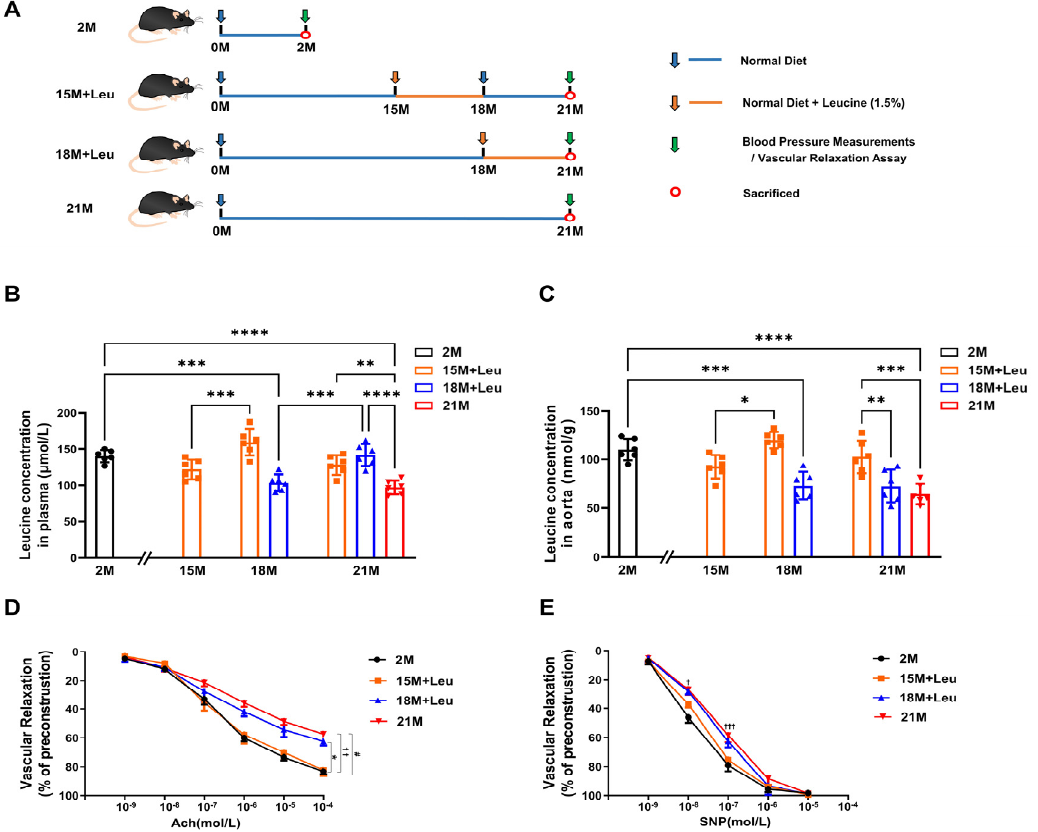
Figure 1. Leucine supplementation from 15M alleviated aging-induced vascular dysfunction. The design of study is shown in ( A ). Measurements of leucine levels in plasma and aorta are shown in ( B , C ). Acetylcholine − mediated endothelium − dependent relaxation and SNP − mediated endothe- lium − independent relaxation are presented in ( D , E ). Statistical analysis of leucine measurements was performed using one − way ANOVA, * p < 0.05, ** p < 0.01, *** p < 0.001, **** p < 0.0001. Statistical analysis of vascular relaxation curves was performed using two − way ANOVA, * p < 0.05 18M + Leu vs. 2M group, † p < 0.05 21M vs. 2M group, †† p < 0.01 21M vs. 2M group, ††† p < 0.001 21M vs. 2M group, # p < 0.05 18M + Leu vs. 15M + Leu group. All data are presented as mean ± SEM, n = 6/group. Vascular remodeling was determined using H&E, Masson’s Trichrome, and van Gie- son’s staining. Compared with the aged group without leucine supplementation, the aor- tas from the 15M + Leu group had a 15.1% reduction in the lumen diameter and a 14% decrease in the medial layer thickness (Figure 2A,D,E). Masson’s Trichrome staining re- vealed collagen content in the medial layer was significantly increased in the aged group, whereas leucine supplementation from 15 months reduced aging − induced collagen dep- osition (Figure 2B,F). Additionally, the mice with leucine supplementation starting from 15 months ameliorated the elastin loss and promoted the normalization of vascular struc- ture (Figure 2C,G). By contrast, these improvements were not observed in the 18M + Leu group.